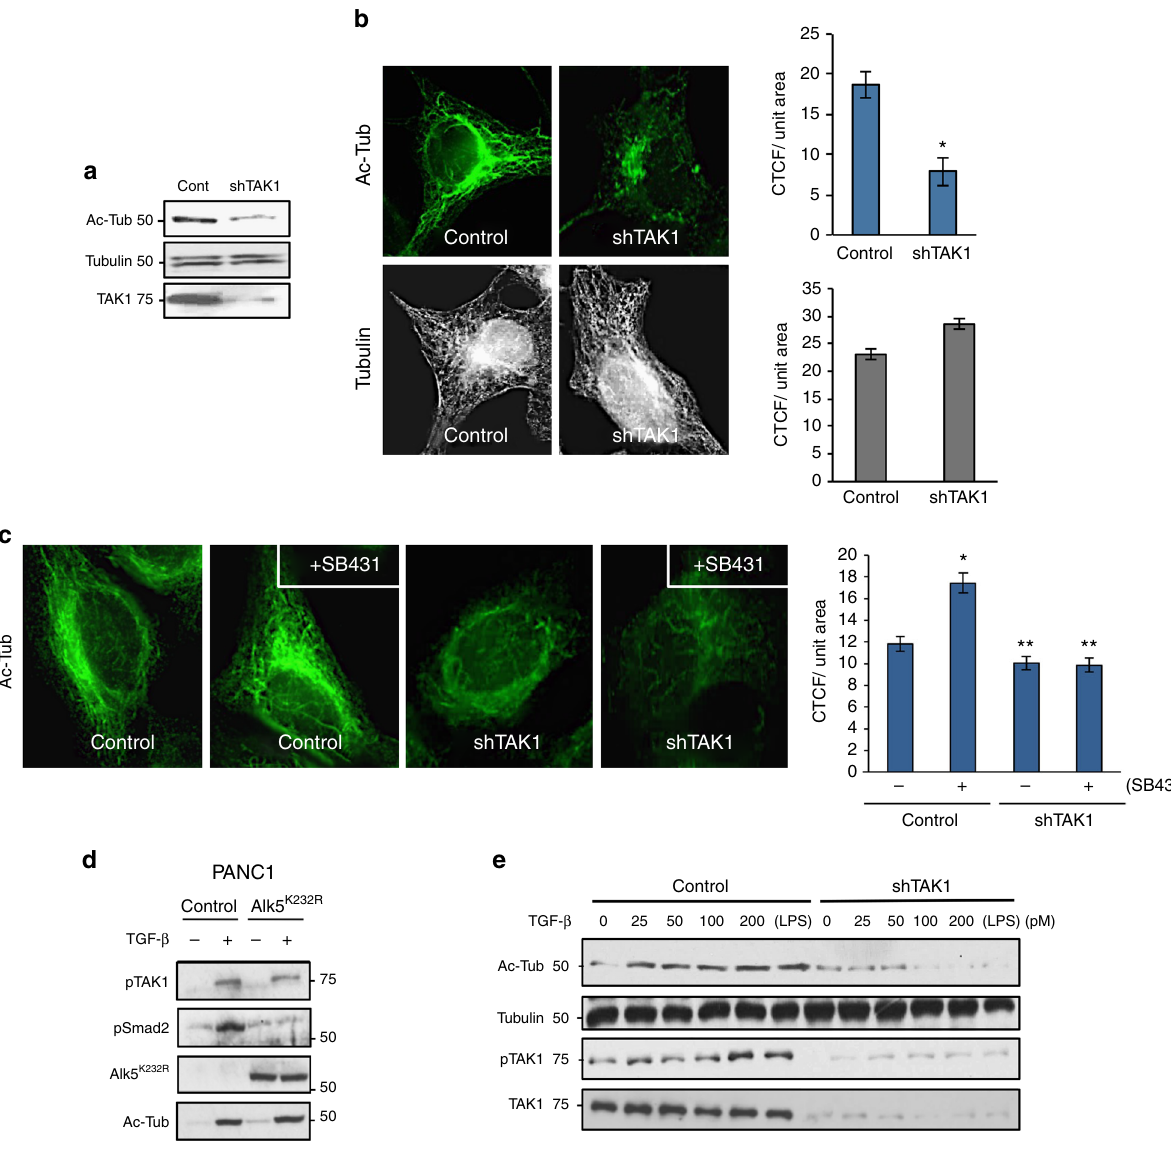
Fig. 2 TAK1 depletion abrogates TGF- β -induced MT acetylation. a Western blot analysis of acetyl-tubulin, total tubulin, and total TAK1 in control HeLa and sh-TAK1 stable cells. b Control HeLa and sh-TAK1 stable cells imaged for acetyl tubulin and total tubulin immuno fl uorescence staining. The images were quanti fi ed for CTCF using Image J. At least 30 cells per condition were quanti fi ed, the images are representative of four independent experiments, n = 4. Error bars represent SEM and type 2 t -test show relative to control: * p < 0.001. c Control HeLa and sh-TAK1 stable cells were treated with SB431542 (30 μ M) for 30 min before fi xing and then imaged for acetyl tubulin immuno fl uorescence staining. The images were quanti fi ed for CTCF using Image J. At least 30 cells per condition were quanti fi ed. The images are representative of three independent experiments, n = 3, error bars represent SEM and type 2 t - test show relative to control: * p < 0.05, ** p < 0.01. d Panc1 cells were transiently transfected with PCDNA control vector or myc-ALK5-K232R construct followed by treatment with TGF- β 1 (200 pM; 1 h) before western blot analysis of phospho-TAK1, phospho-Smad2, ALK5-K232R, and acetyl tubulin.